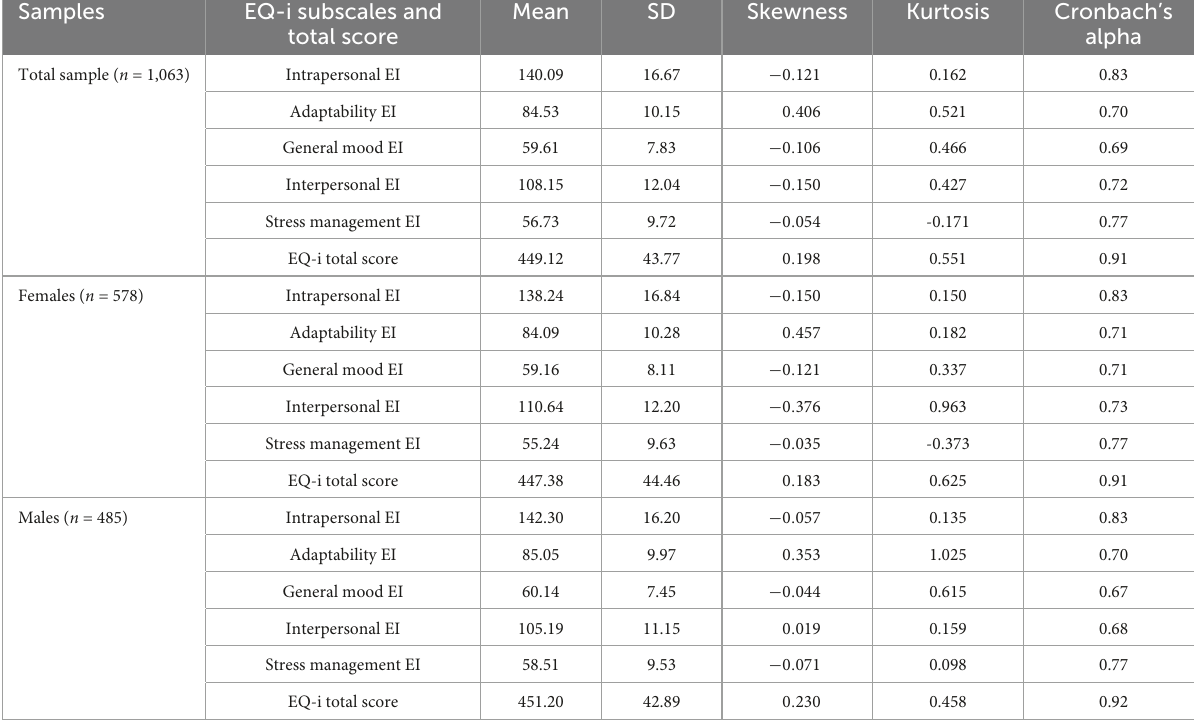
TABLE 1 Descriptive statistics and the internal consistency of the five dimensions and the global score of the EQ-i in total, female, and male samples. Samples